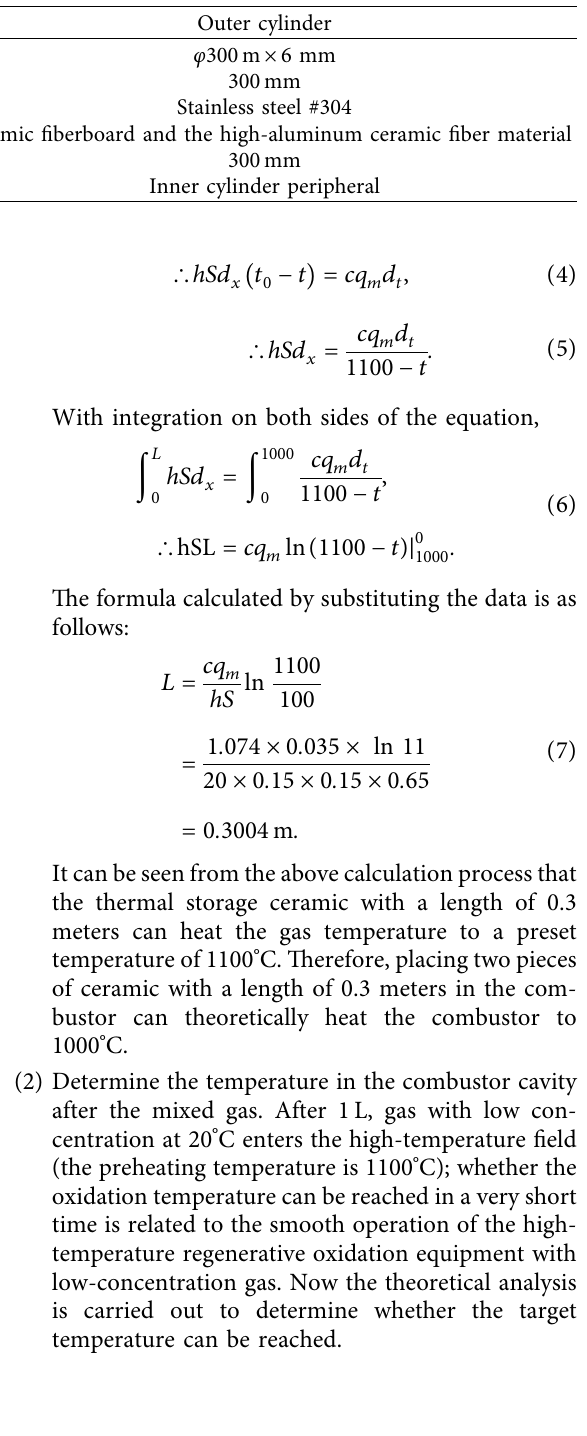
Table 2: The parameter table of the